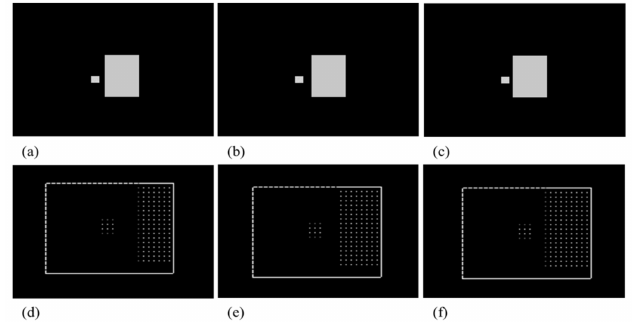
Figure 6. Result of target likelihood obstacle check in test image sequence ( a – c ) are test image sequences, and ( d – f ) show the results of searching candidates for ( a – c ) with magnifying interested area. In ( d – f) , the square box represents the search area spots, meaning a bright block. Calculation result of estimated distance is ( d ) 16, ( e ) 11, ( f ) 6.